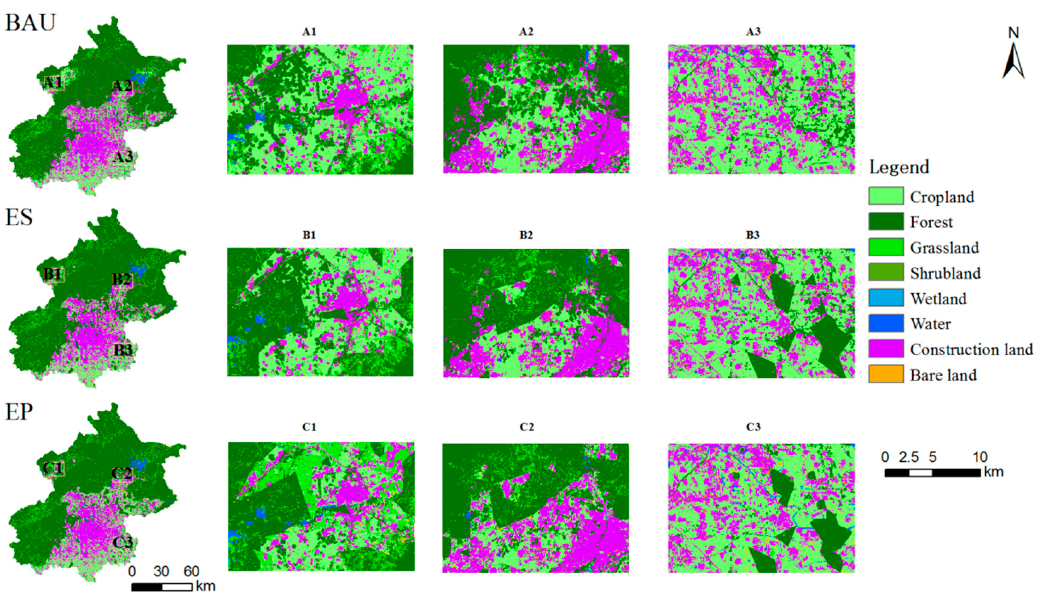
Figure 8. The spatial patterns of land use in 2031 under different scenarios.